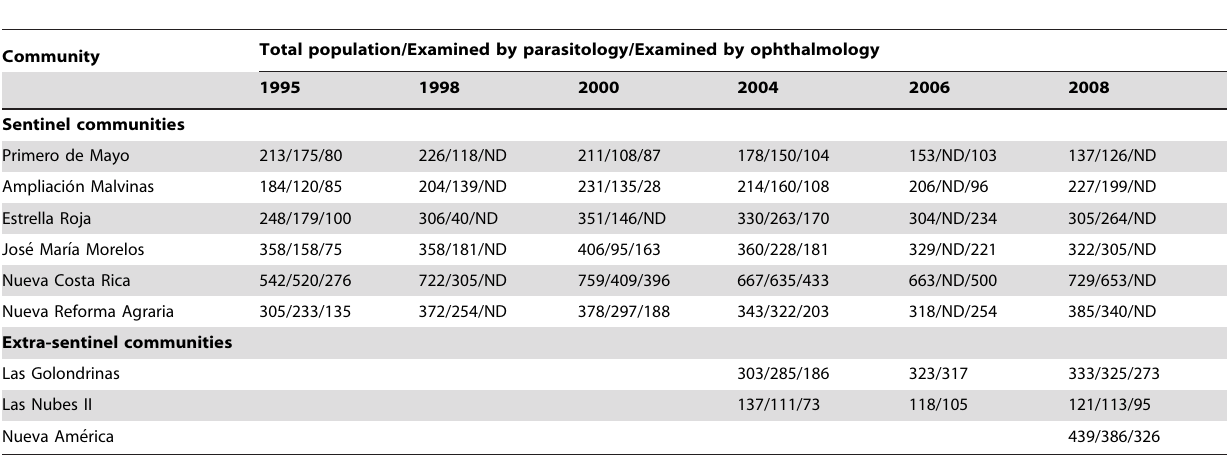
Table 4. Total population and individuals examined by parasitology and ophthalmology in Southern Chiapas focus.